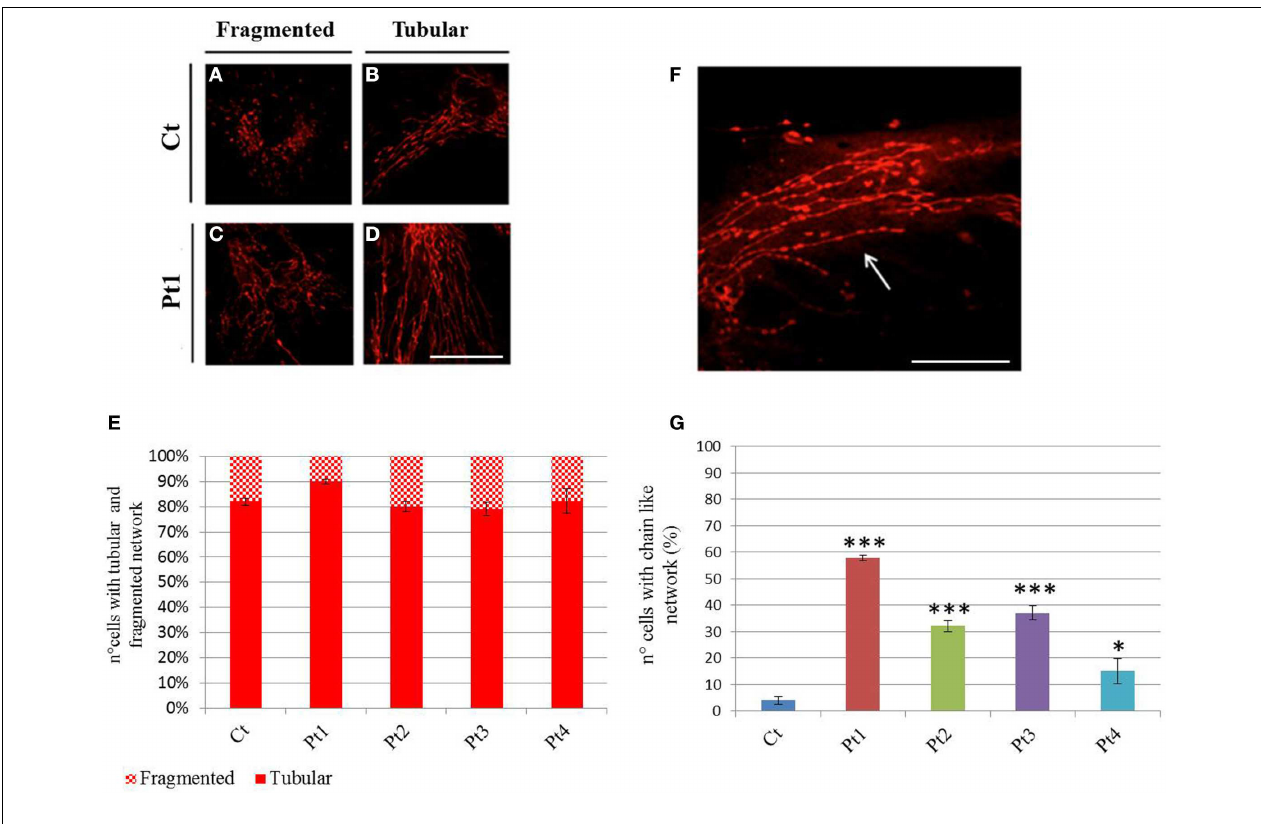
Pt3, Pt4) and controls (Ct). Test Chi 2 -Pearson (Pt vs Ct) was performed and resulted not-significant for all mutant fibroblasts; p: 0,10 (Pt1); p: 0,72 (Pt2); p: 0,59 (Pt3); p: 0,97 (Pt4). (F) Mitotracker Red staining showing a peculiar mitochondrial “chain-like” network (arrow), observed virtually only in mutant fibroblasts. Scale bar, 100 µ m. (G) Quantification of cells with “chain-like” structure after Mitotracker Red staining. Data were from three independent experiments, each with 50 counted cells. Test Chi 2 -Pearson (Pt vs. Ct); p: 1,83E-16 (Pt1); p: 2,56E-07 (Pt2); p: 7,46E-09 (Pt3); p: 0,008 (Pt4). ∗∗∗ p < 0 . 0001 ; ∗ p < 0 . 01